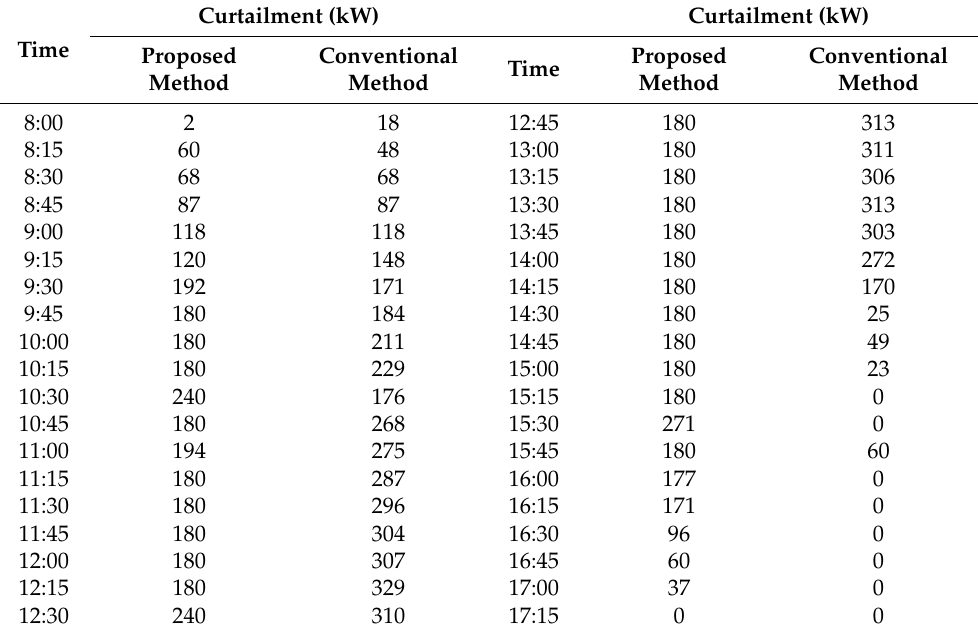
Table 3. Optimal PV curtailment scheduling results during generation time.